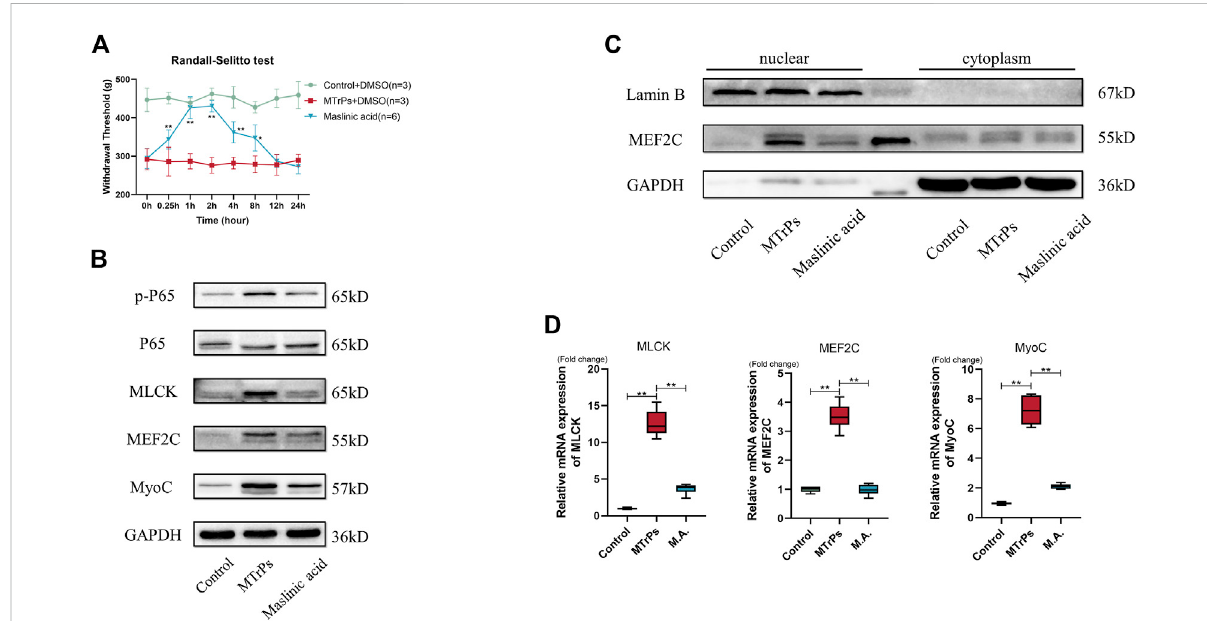
FIGURE 4 (A) Effect of Maslinic acid on mechanical withdrawal thresholds in MTrPs rats ( n = 5). M.A. (5 mg/ml) after intramuscular injection at 0.25, 1, 2, 4, and 8 h rescued the decrease of mechanical withdrawal threshold in MTrPs rats. (B) . Expression of p-P65, P65, MLCK, MEF2C, and MyoC was detected 1 h after M.A. or DMSO injection, and the protein expression of p-P65, MLCK, MEF2C, and MyoC in the M.A. group was signi fi cantly lower than that in the MTrPs group. (C) . The nuclear protein expression of MEF2C in the M.A. group was lower than that in the control group, with GAPDH as the cytoplasmic protein internal reference and Lamin B as the cytosolic protein internal reference. (D) . The mRNA expression levels of MLCK, MEF2C, and MyoC in the M.A. group were signi fi cantly lower than those in the MTrPs group, using GAPDH as the internal reference